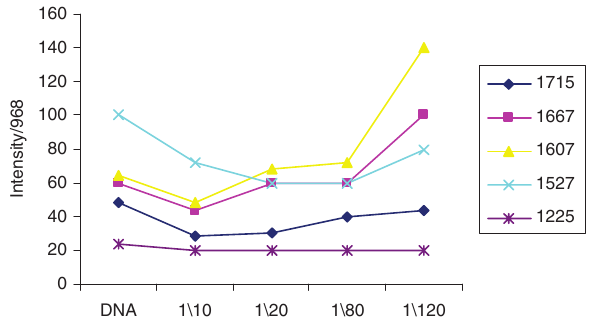
Figure 4: Intensity ratio variations for DNA in-plane vibrations as a function of STZ concentrations (0.05–12.5 mm). Intensity ratios for the DNA bands at 1715 (G), 1667 (T), 1607 (A), 1527 (C), and 1225 (PO asymmetric) referenced to the DNA band at 2